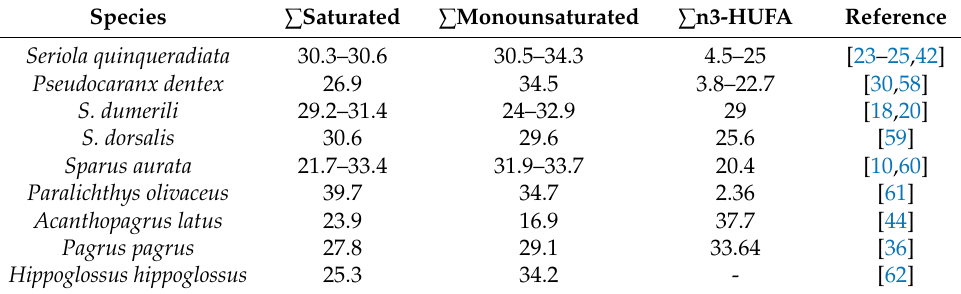
Table 6. Total amounts of fatty acids in broodstock diets. Species ∑ Saturated ∑ Monounsaturated ∑ n3-HUFA